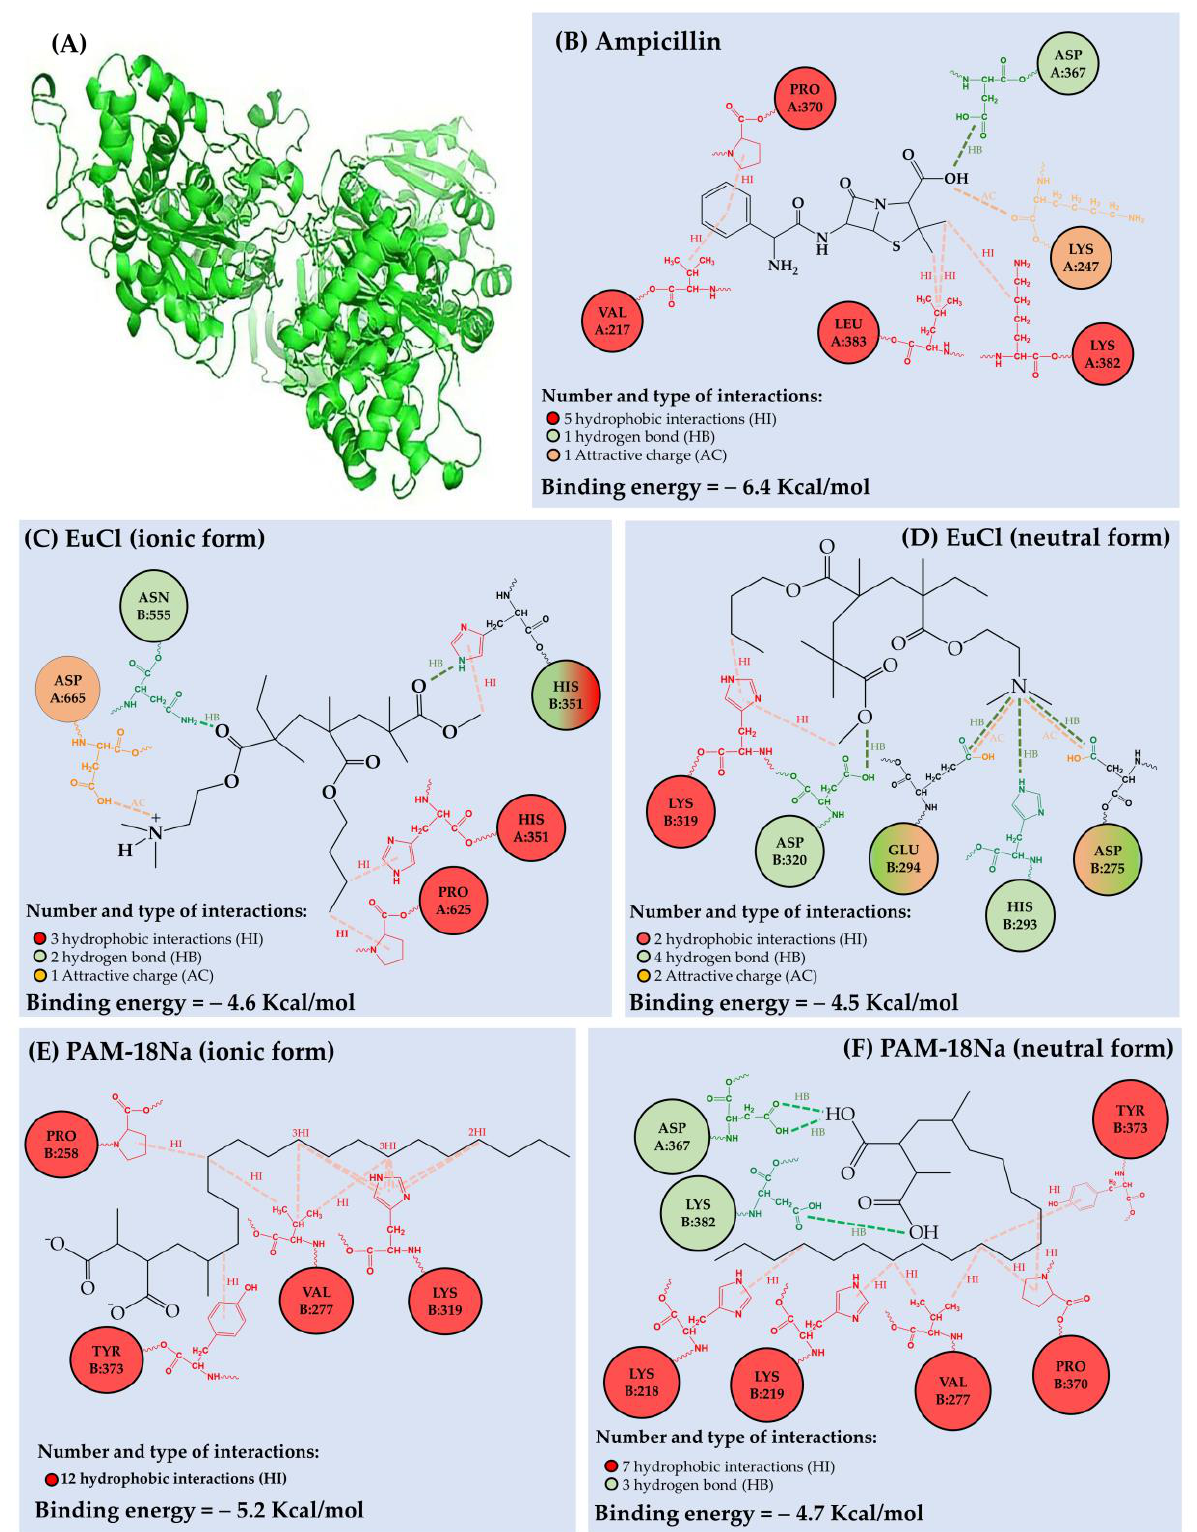
Figure 3. ( A ) Optimized three-dimensional structure of the PBPa2 protein. Scheme of the interactions and coupling free energy between ( B ) PBPa2-ampicillin, ( C ) PBPa2-EuCl (ionic form), ( D ) PBPa2-EuCl (neutral form), ( E ) PBPa2-PAM18Na (ionic form), ( F ) PBPa2-PAM18Na (neutral